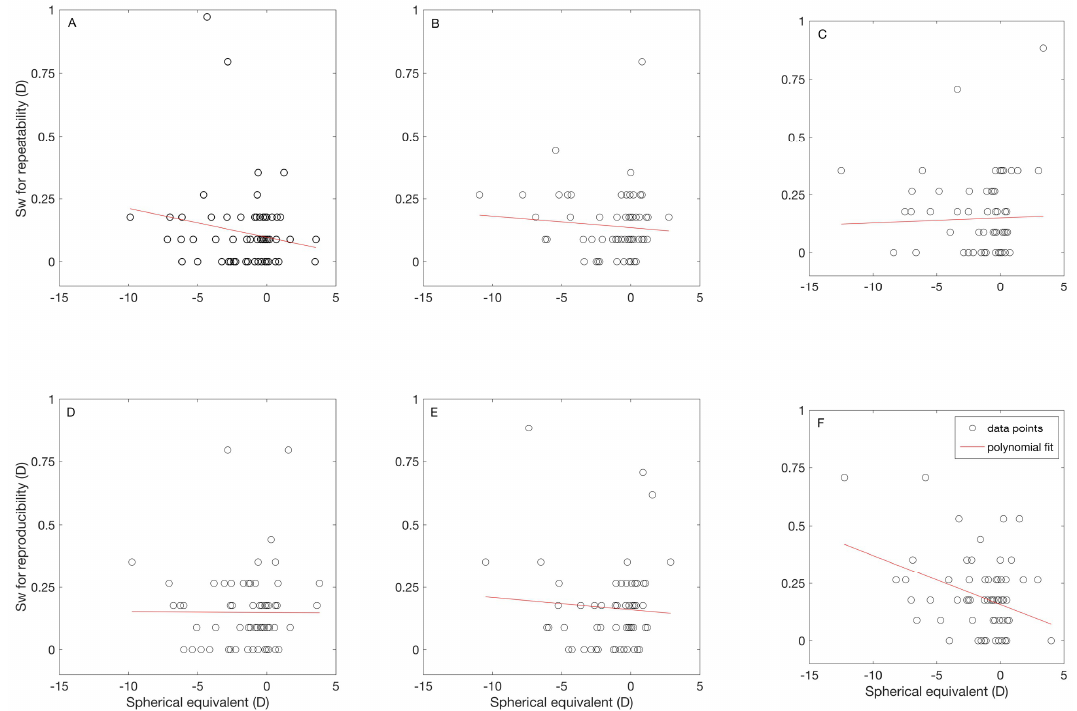
Figure 2. Correlation between spherical equivalent and within subject standard deviation for repeatability ( A – C ) and reproducibility ( D , E ) for each instrument. The results for the binocular instrument with fogging are shown in ( A , D ), for the binocular instrument without fogging are shown in ( B , E ), and for the monocular instrument with fogging are shown in ( C , F ).